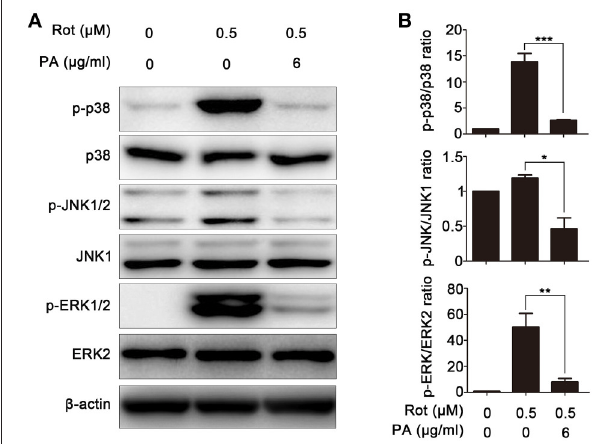
FIGURE 4 | Effects of PA on rotenone-induced ERK, p38, JNK, and ERK phosphorylation in SH-SY5Y cells. (A) Cells were pretreated with various doses (6 µ g) of PA for 4h before rotenone (0.5 µ M) stimulation for 1h. Samples were assessed by western blot with antibody against p-p38, p-ERK1/2, and p-JNK. A non-phosphorylated form of each targeted protein was used as loading control. β -Actin was used as an internal control. Results are representative of at least three experiments. (B) The levels of phosphorylated ERK, p38, and JNK were quantified by densitometry, * p < 0.05, ** p < 0.01, *** p < 0.001, vs. control group.